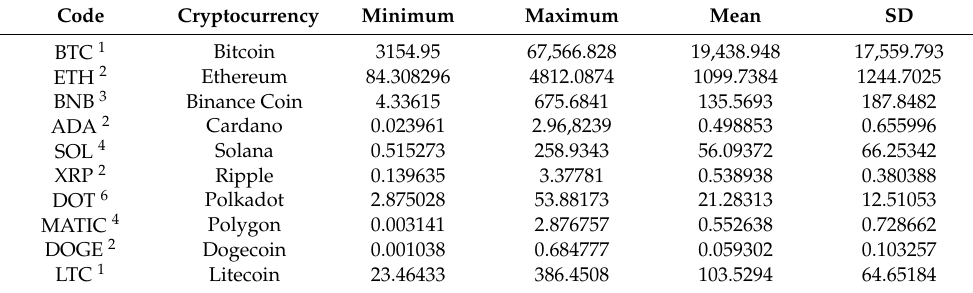
Table 3. Ten cryptocurrencies’ data.